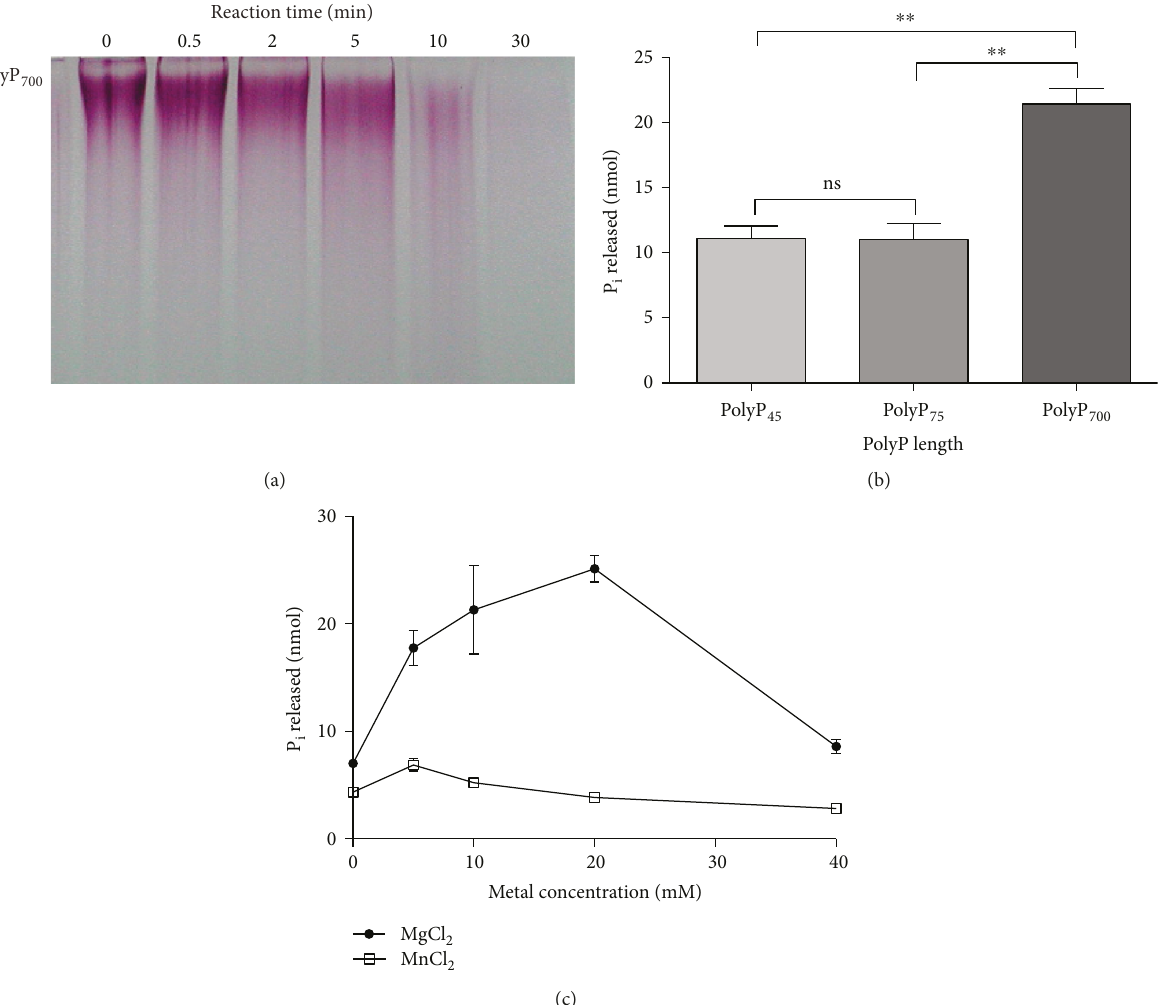
Figure 2: The gene Msed_0891 encodes for a functional exopolyphosphatase. (a) In vitro enzymatic PPX activity assay of the protein encoded by Msed_0891. PPX was incubated with PolyP as described in Materials and Methods at 65 ° C for the times indicated. The remaining Msed 700 PolyP in the samples was visualized by UREA-PAGE. (b) Substrate preference of PPX . The enzyme was incubated with the PolyP of Msed di ff erent chain lengths indicated, as described in Materials and Methods. (c) E ff ect of MgCl and MnCl in PPX activity. PPX activity 2 2 Msed was determined at the indicated metal concentrations ( ∗∗ P < 0 01